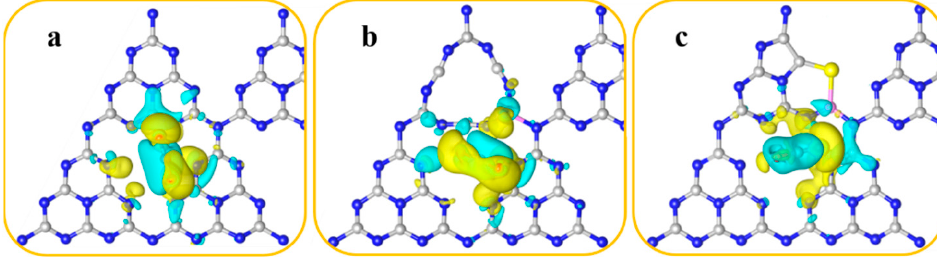
Figure 5. The map of differential charge density for g-C 3 N 4 ( a ), B-F-N v ( b ), and B-S-N v ( c ).